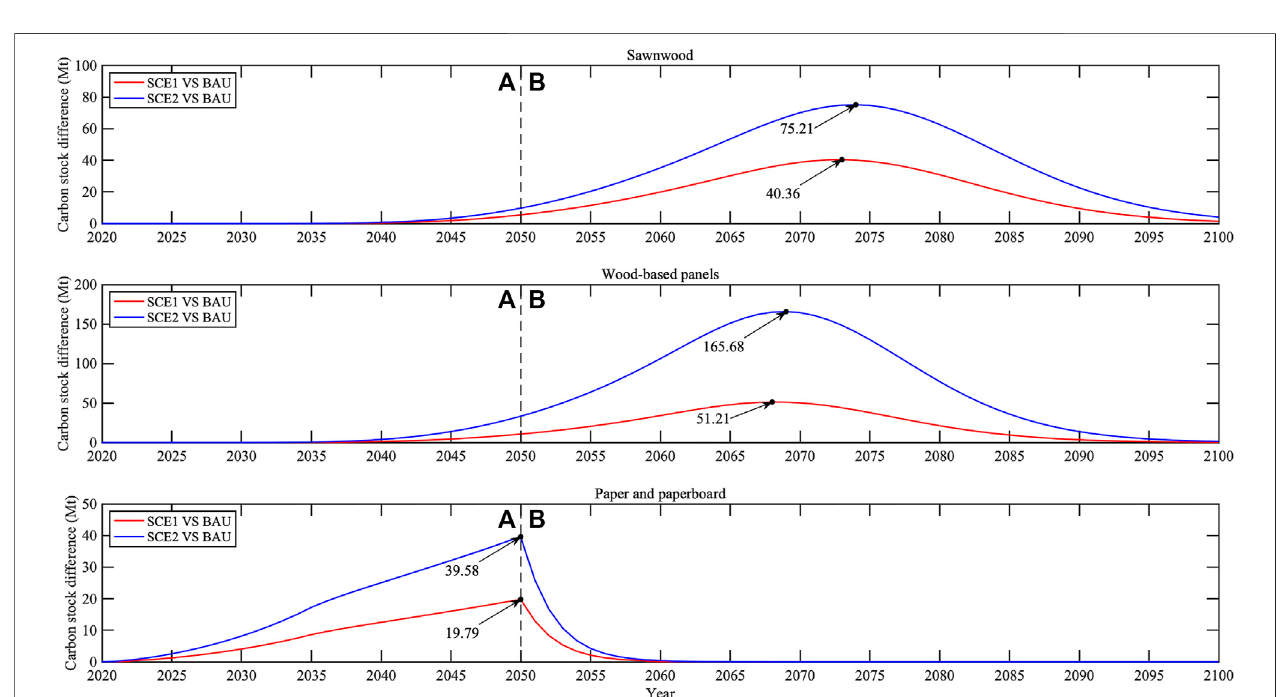
FIGURE 6 | Carbon stock difference between different wood utilization scenarios. The carbon stock different in Part A (2020 – 2050) took into account both in fl ow and decay.The carbon stock different in Part B (2051 – 2100) only considered the decay of HWP carbon pool in China since 2051. The black arrows and numbers in the fi gure show the maximum difference of carbon stock of three HWP semi- fi nished products under different wood utilization scenarios.